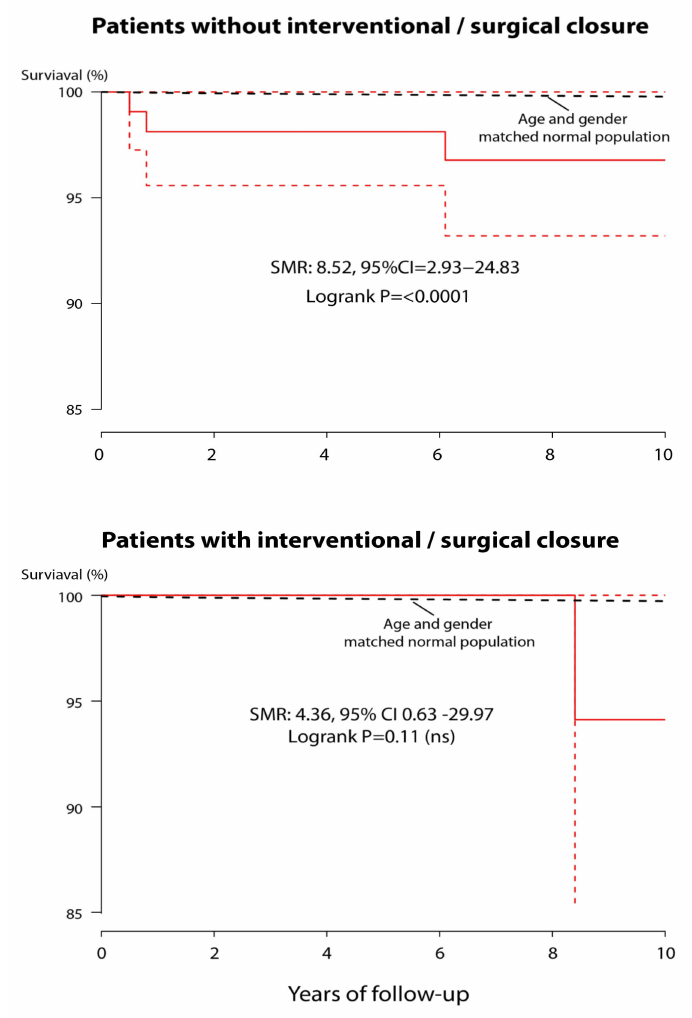
Figure 3. Survival of the Trisomy 21 ASD population (with 95% confidence intervals—dotted line) stratified by amenability to interventional or survival defect closure compared to that of an age and gender matched sample of the general population. For details see text. SMR = standardized mortality ratio. ASD refers specifically to ASD